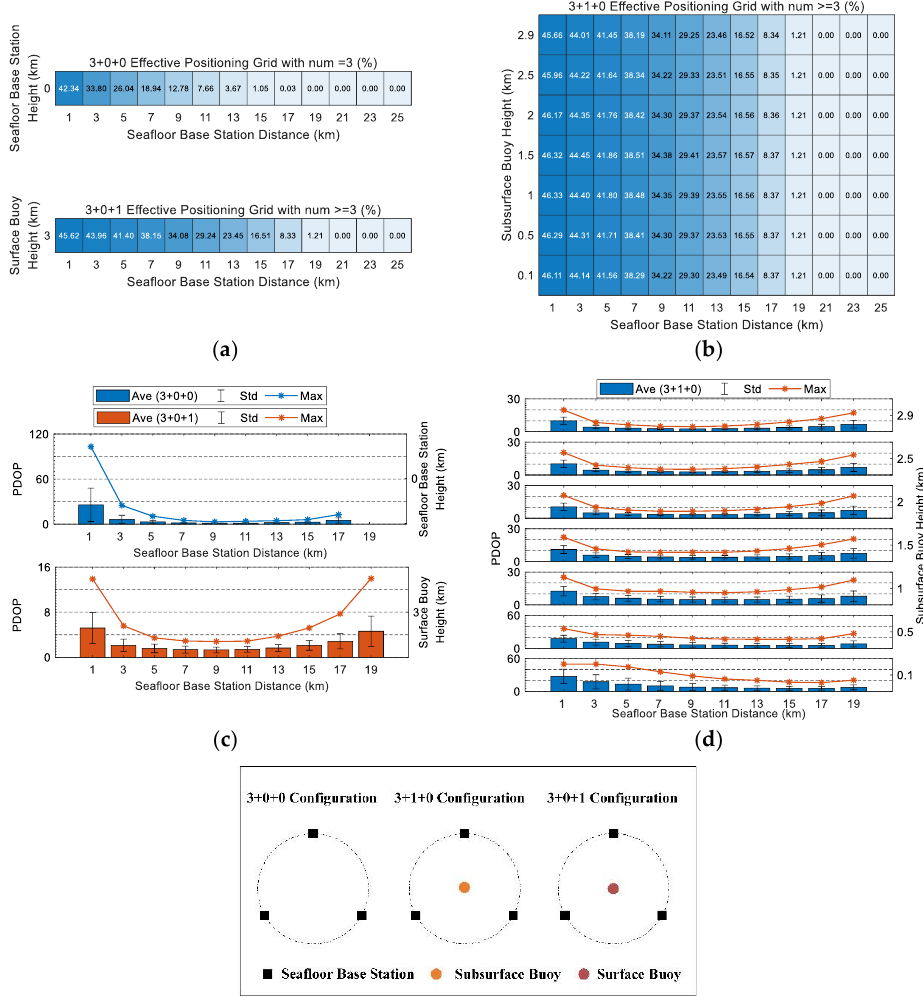
Figure 4. User positioning indicators of the “3+0+0”, “3+0+1”, and “3+1+0” network configurations. ( a , b ) Heat maps of the percentage of EPGs with the number of available base stations ≥ 3; ( c , d ) average, standard deviation, and maximum PDOP — the box denotes the average, the black vertical line denotes the standard deviation, and the asterisk line denotes the maximum value. The results for the “3+0+0” configuration and the “3+0+1” configuration are shown in subfigure ( c ), whereas the “3+1+0” configuration with a subsurface buoy height of 0~2.9 km is shown in subfigure ( d ).